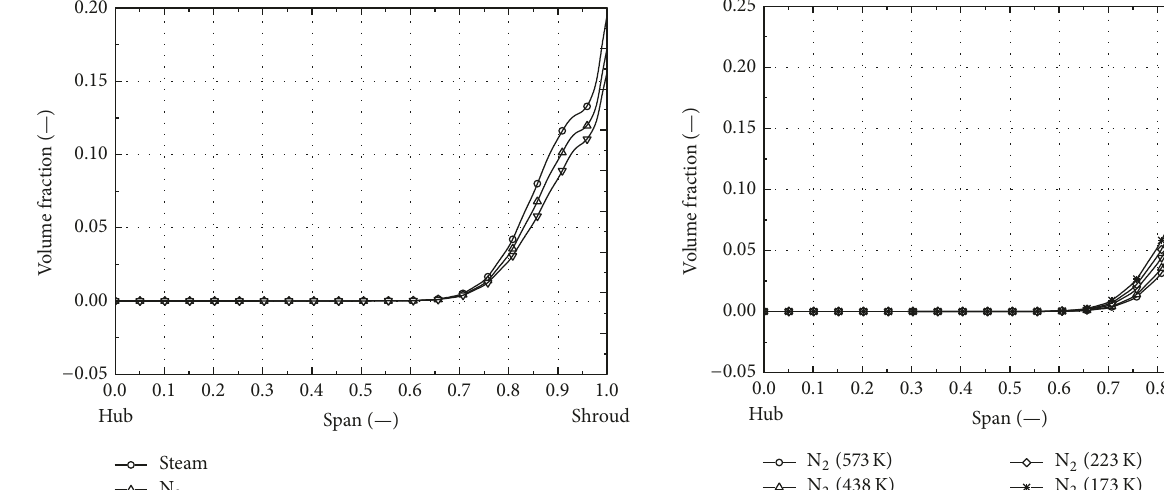
diffuser inlet flow angle decreases from hub to shroud. The higher gas temperature can reduce 0.87–1 span flow angle and enhance it at 0–0.87 span and thus increase span averaged flow angle.